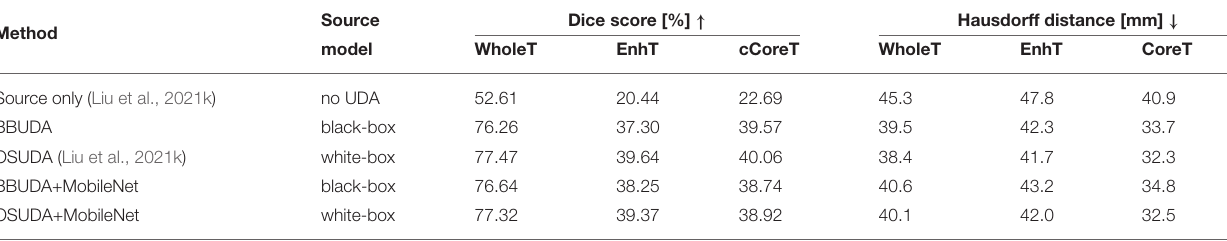
TABLE 4 | Comparison of T1 to T2 black-box UDA.